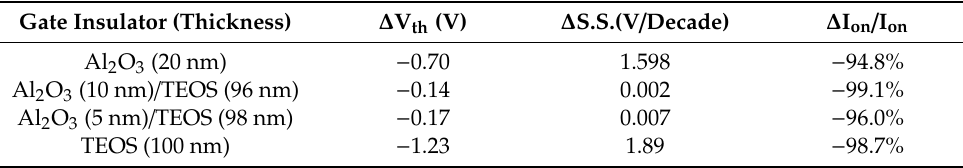
Figure 5. Representative transfer characteristics of a-IGZO TFTs with ( a ) Al 2 O 3 (20 nm), ( b ) Al 2 O 3 (10 nm) / TEOS oxide (96 nm), ( c ) Al 2 O 3 (5 nm) / TEOS oxide (98 nm) and ( d ) TEOS oxide (100 nm) gate dielectrics, respectively, as a function of stress over time under a negative bias stress (NBS) (V GS = − 20 V). Table 3. Variations of extracted electrical parameters of a-IGZO TFTs with four kinds of gate dielectrics after NBS stress for 6400 s (V GS = − 20